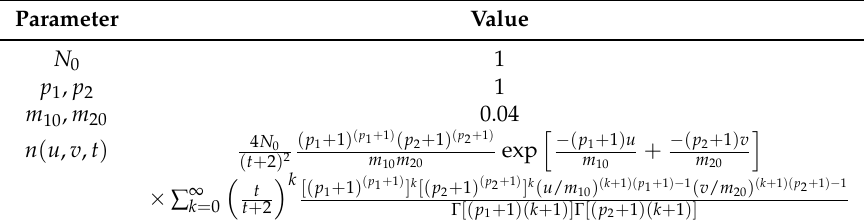
Table 1. Analytical solutions of number density functions for size-independent kernel.